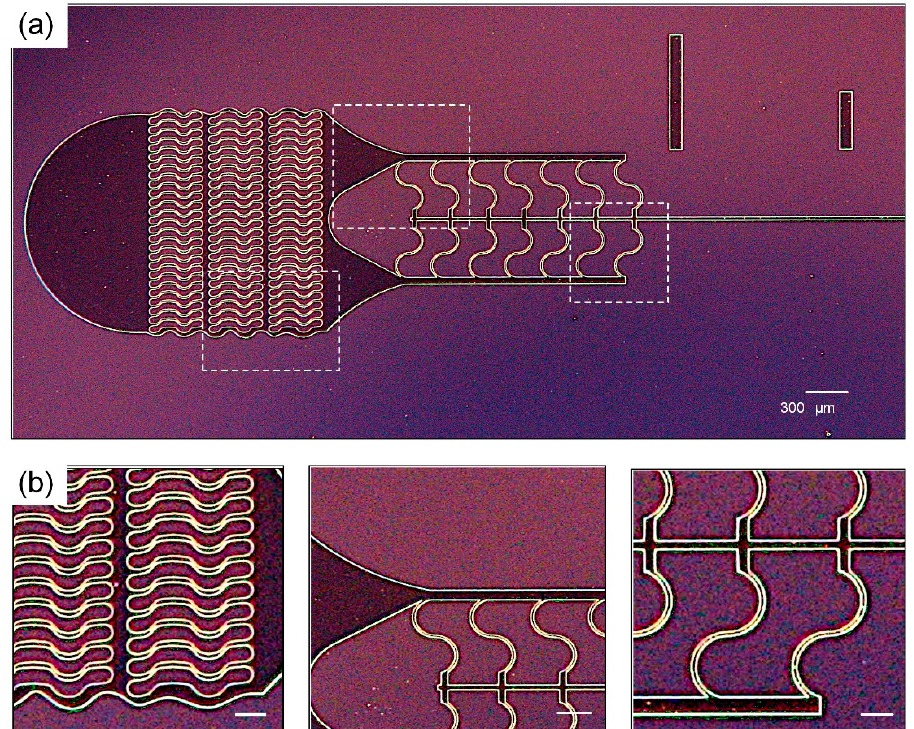
Figure 2. Representative images of a completed ADEX master using optimized process parameters. ( a ) Image of the channel inlets filters, with 30 µm spacing between each filter pillar. The scale bar is 300 µm; and ( b ) close-up images of different channel sections. The scale bar is 50 µm.